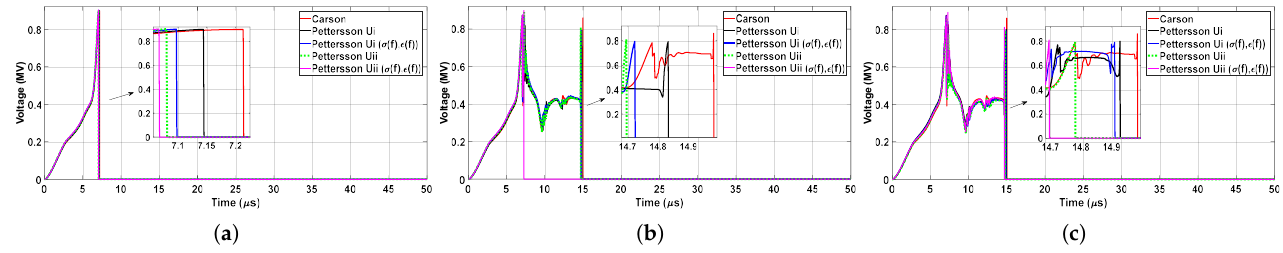
Figure 17. Overvoltage waveforms in phases A ( a ), B ( b ) and C ( c ), with or without a disruption process (backflashover), considering ground resistivity equal to 10,000 Ω .m. and a lightning stroke current waveform with α = 1.47.